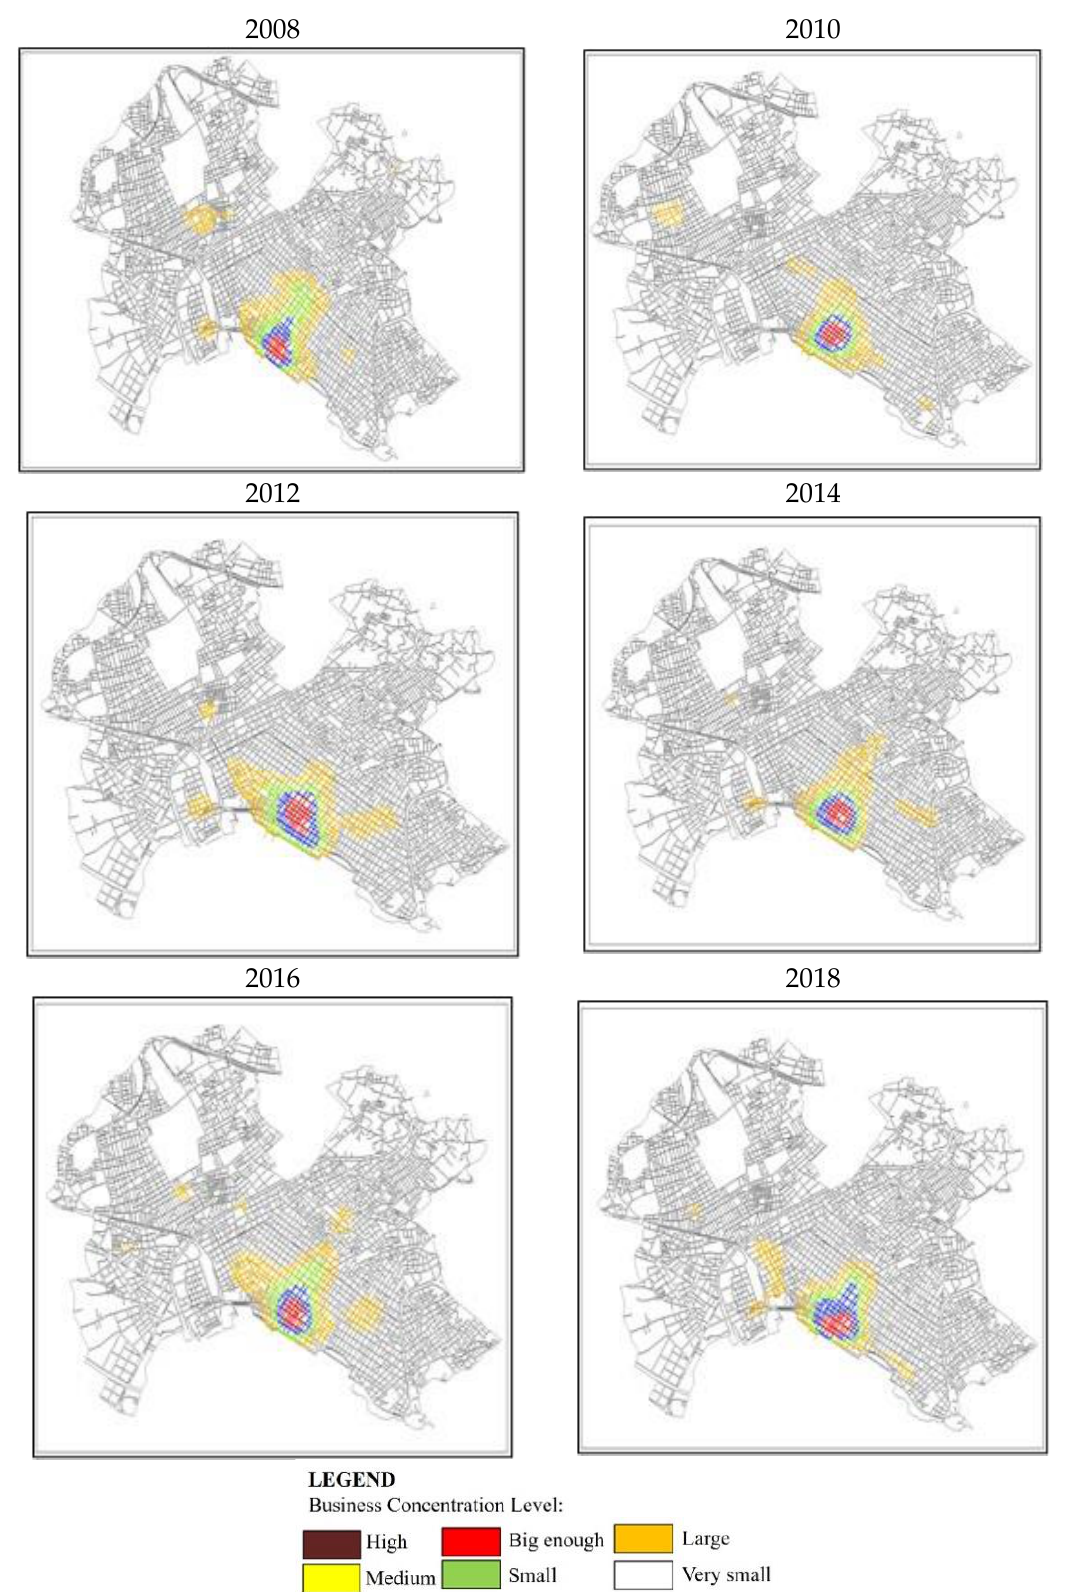
Figure 7. Network-based kernel density for the years 2008 – 2018 for all companies, Source: Chamber of Magnesia, Own processing.